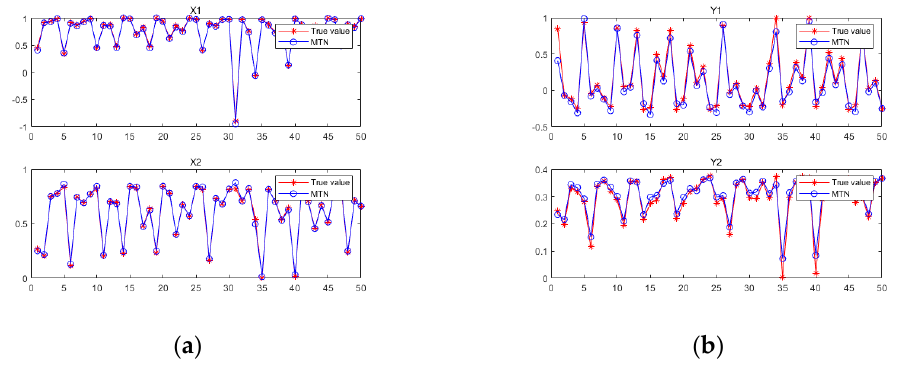
Figure 6. ( a ) Graph of the MTN identify the state equation in case 2. ( b ) Graph of the MTN identify the measurement equation in case 2.